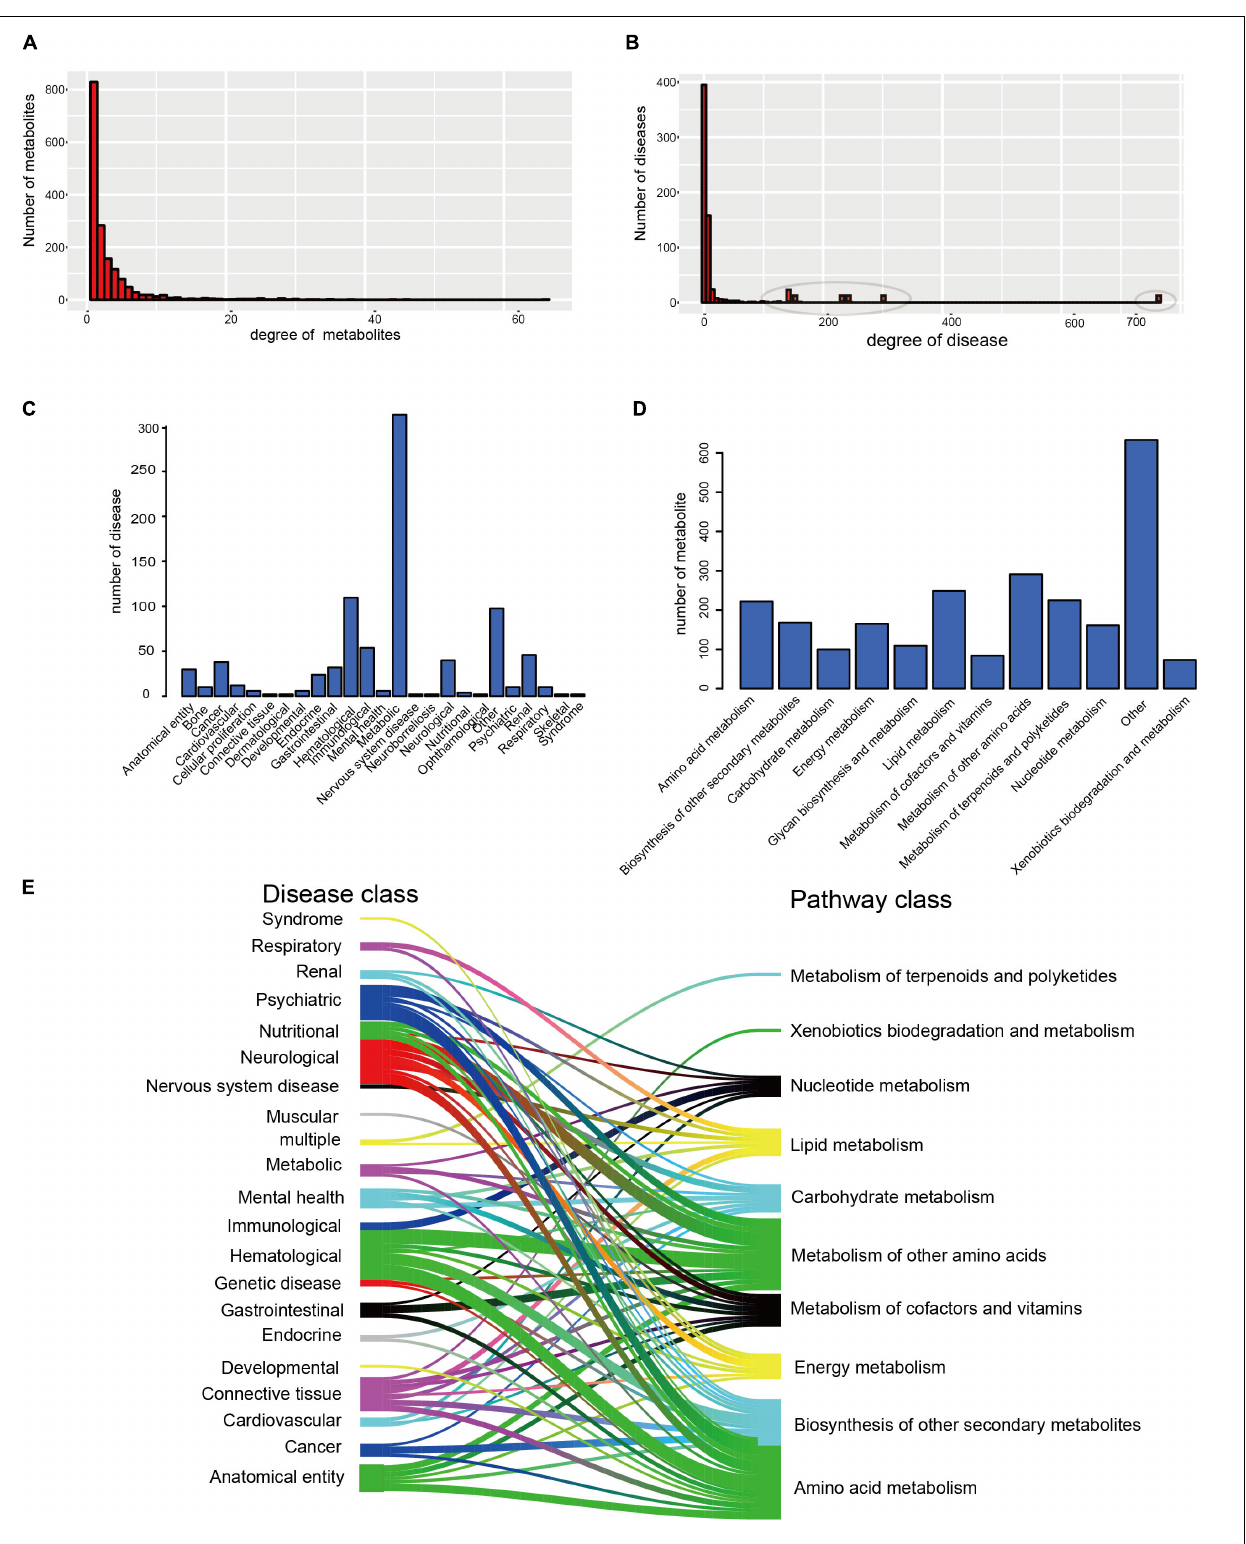
FIGURE 2 | The basic network features of the HDMN. (A) Distribution of the number of mapped metabolites. (B) Distribution of the number of mapped diseases. (C,D) The distribution of nodes in the different disease and metabolic pathway categories. (E) The distribution of metabolites in each disease class in 12 metabolic pathways was calculated according to the hypergeometric test ( P -value <